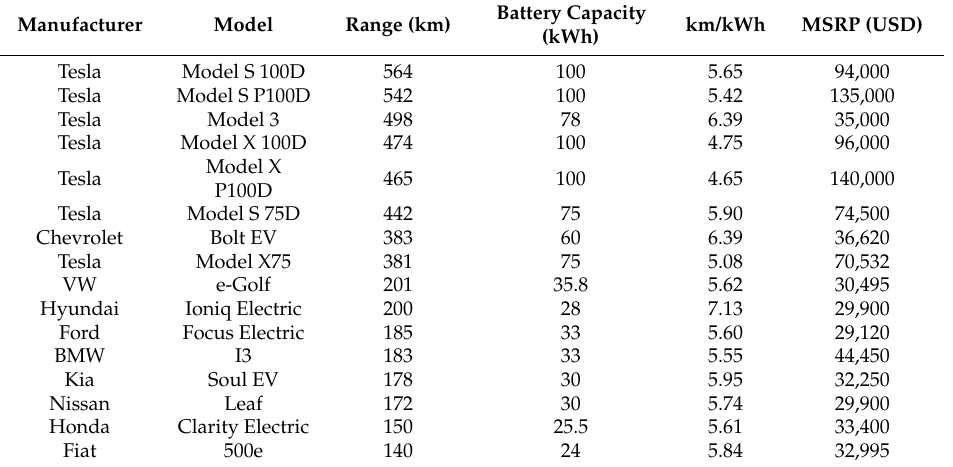
Table 5. EV manufacturers and models with range, battery capacity, per kWh energy consumption, and manufacturer’s suggested retail price